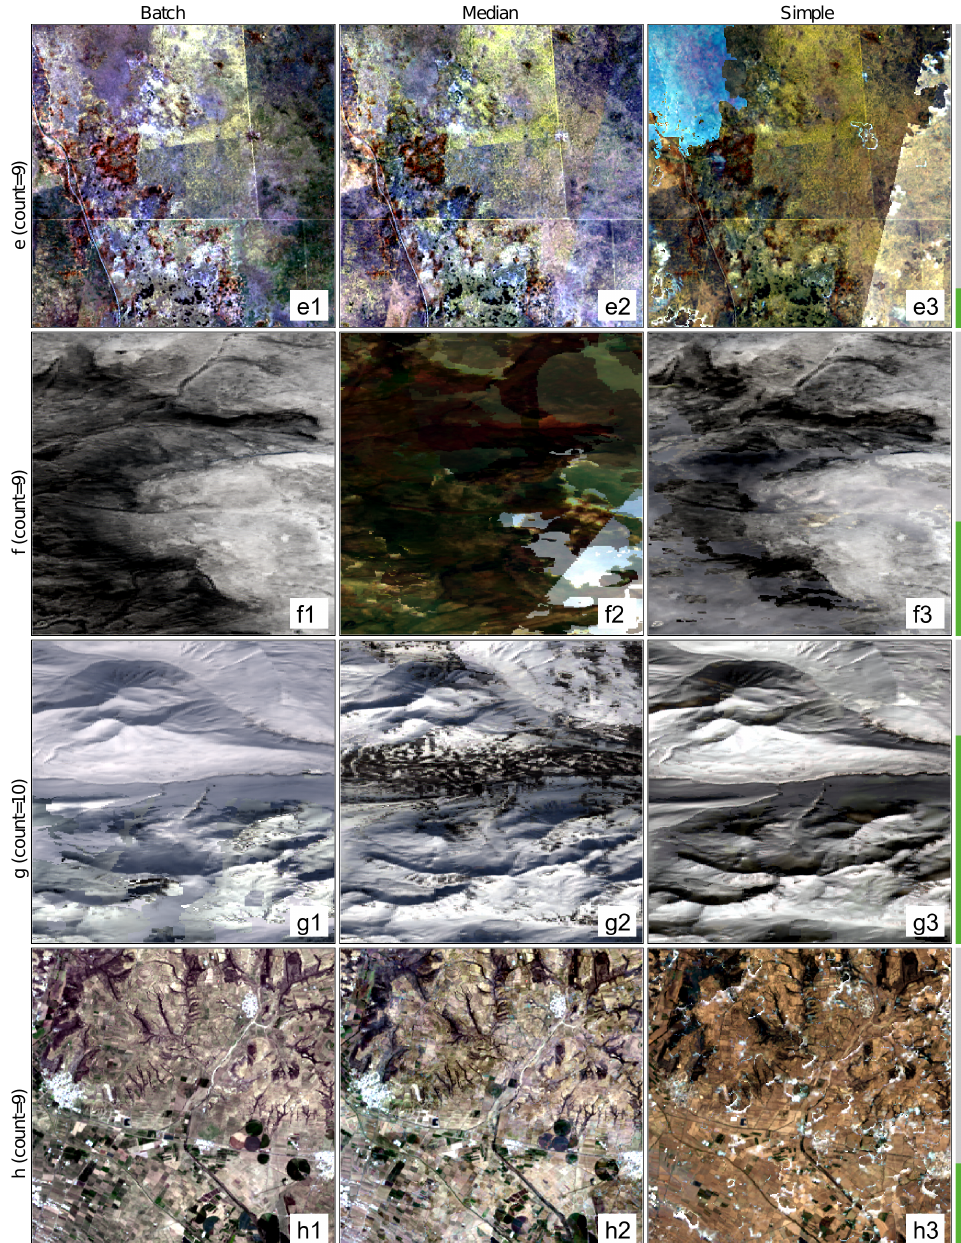
Figure 9. Visual comparison part 2: band 4/3/2 composition produced using different algorithms at locations from ( e – h ). Each location discloses the number of available image scenes (count variable from the left edge) and the average cloud coverage. The latter is represented by the vertical progress bar (max is 100%) on the right edge; ( e1 , f1 , g1 , h1 ) are produced with the batch algorithm, ( e2 , f2 , g2 , h2 ) are produced with the median algorithm, and ( e3 , f3 , g3 , h3 ) are produced with the simple